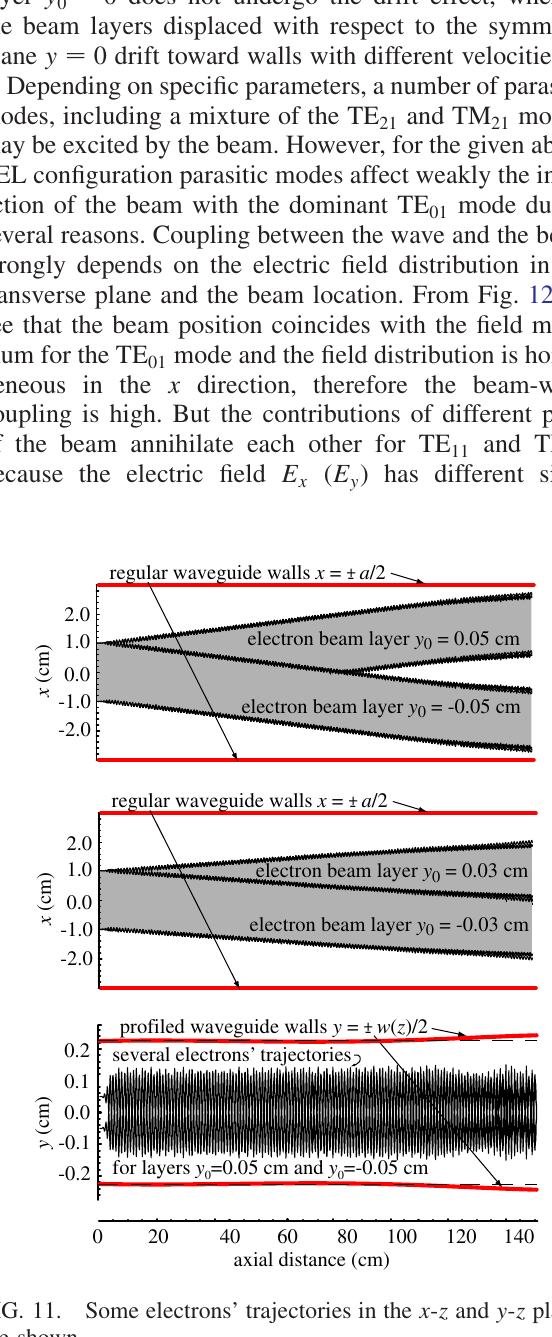
FIG. 10. The normalized power vs the interaction length at different moments of time.